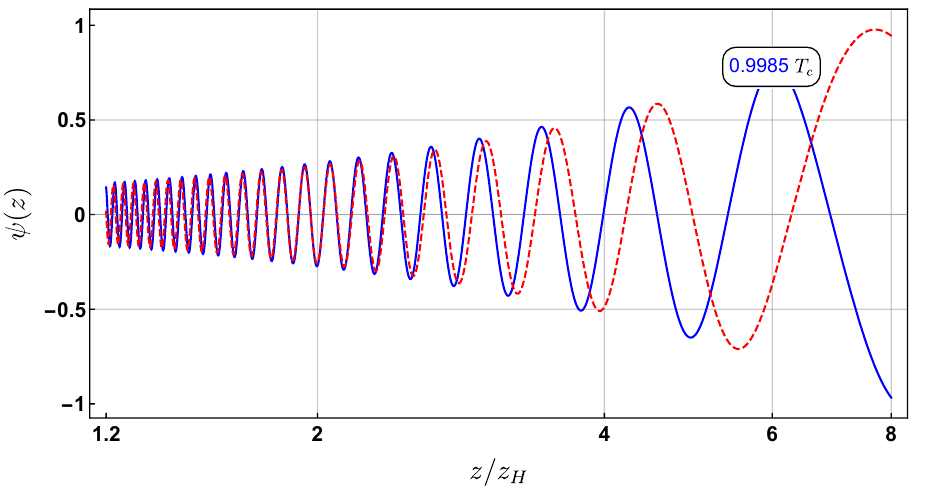
Figure 7 . A comparison of the numerical solutions (solid blue curve) and the analytical descrip- tion (3.3) (red dashed curve) for Josephson oscillations. The approximation is in excellent agreement to the numerical solution when ψ is small ( z/z . 3 ), and loses its effectiveness at large z for which H ψ is not small. We choose T = 0 . 9985 T c with µ = 1